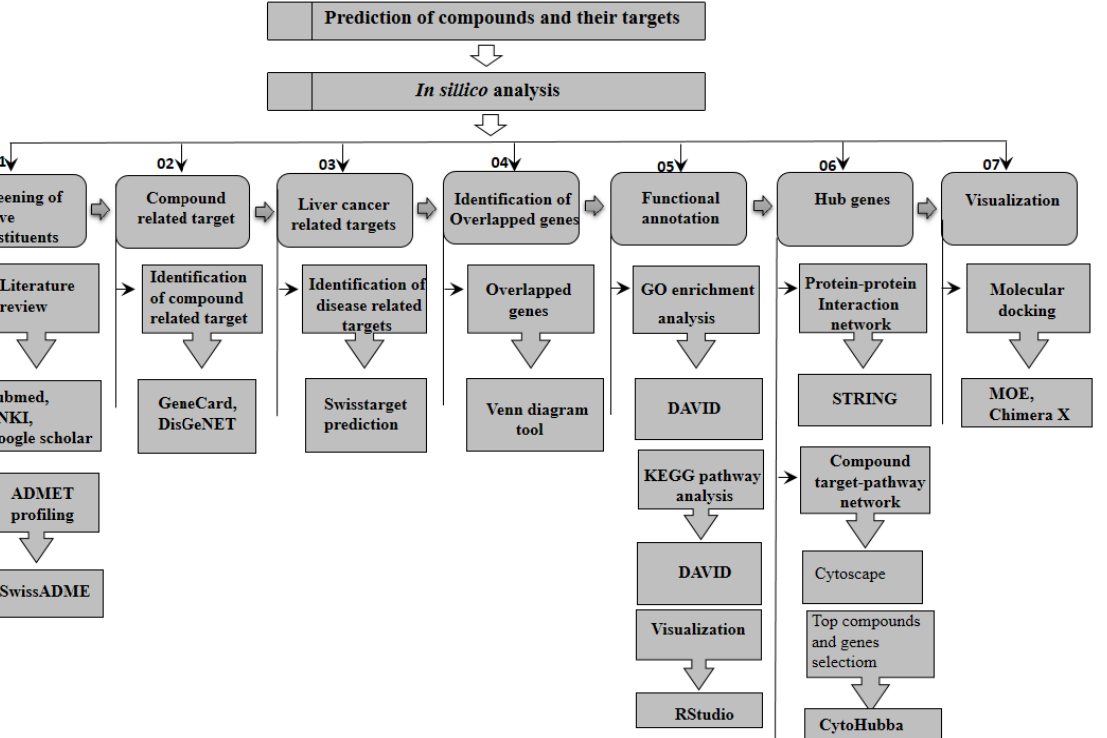
Figure 5. Graphical synopsis representing the overall strategy used in the prediction of potential compounds and their potential targets for liver cancer treatment.